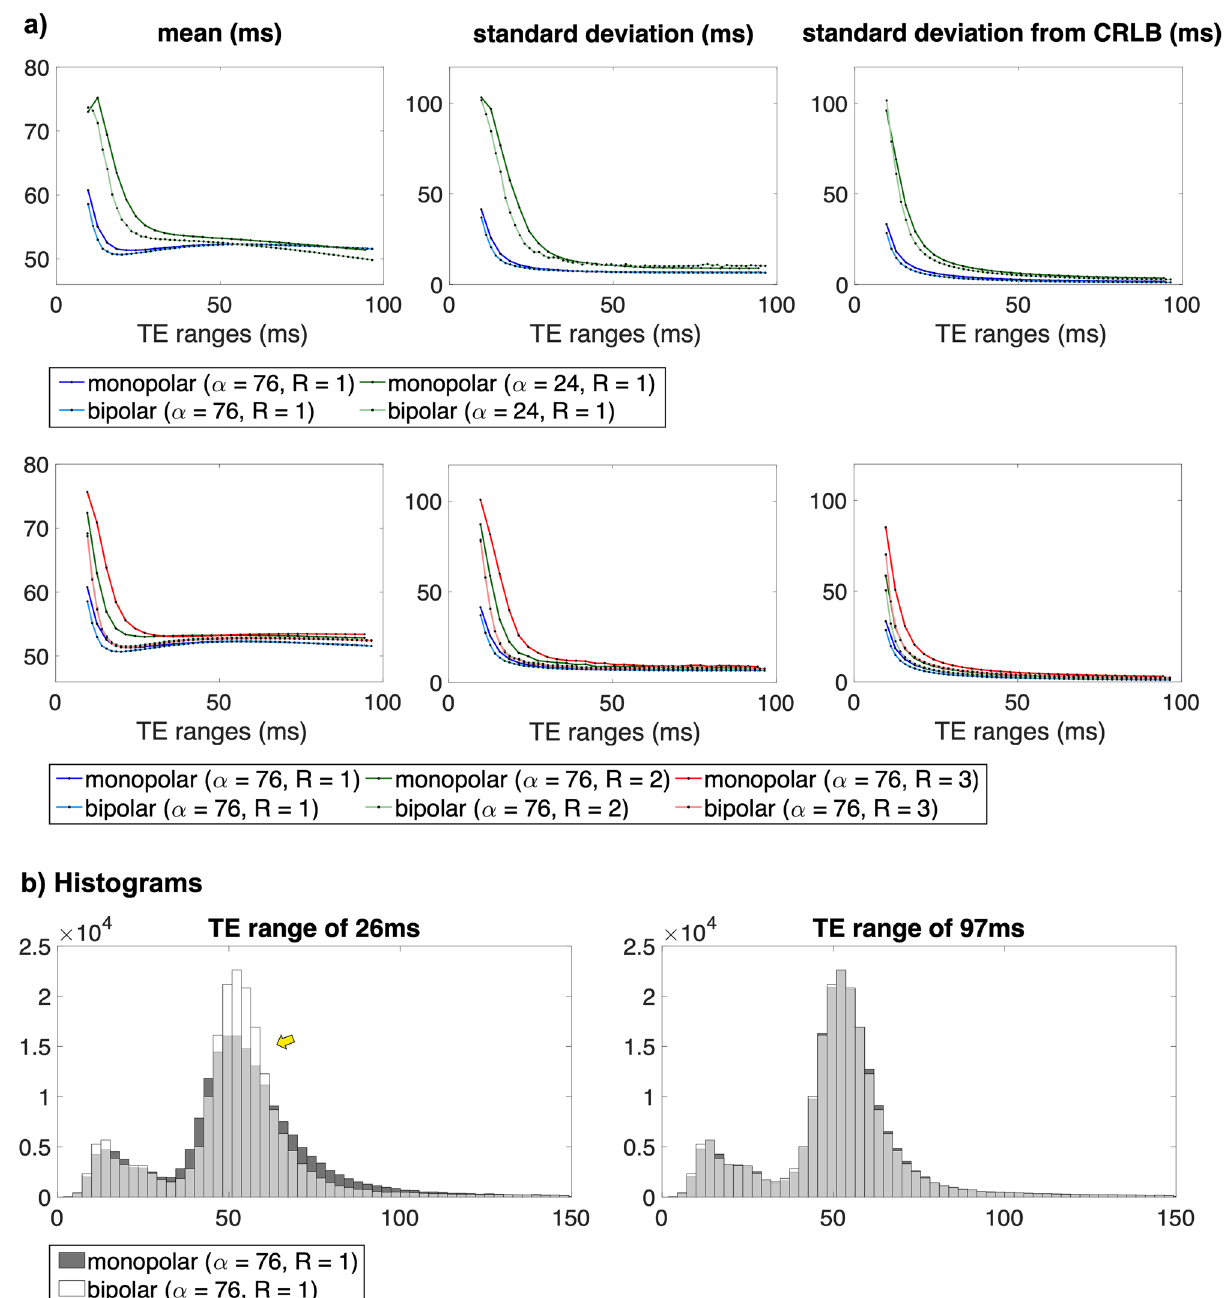
Figure 5. ( a ) Plots of the mean and standard deviation of the T2*s calculated in white matter from one healthy volunteer. Imaging parameters: BW/px = 801, ∆TE = 2.92 ms for monopolar and 1.47 ms for bipolar, and TR = 1200 ms. ( b ) Histograms for the whole brain when the TE range is 26 ms (left) and 97 ms (right), respectively. Imaging parameters: BW/px = 801, ∆TE = 2.92 ms for monopolar and 1.47 ms for bipolar, TR = 1200 ms, α = 76°, R =